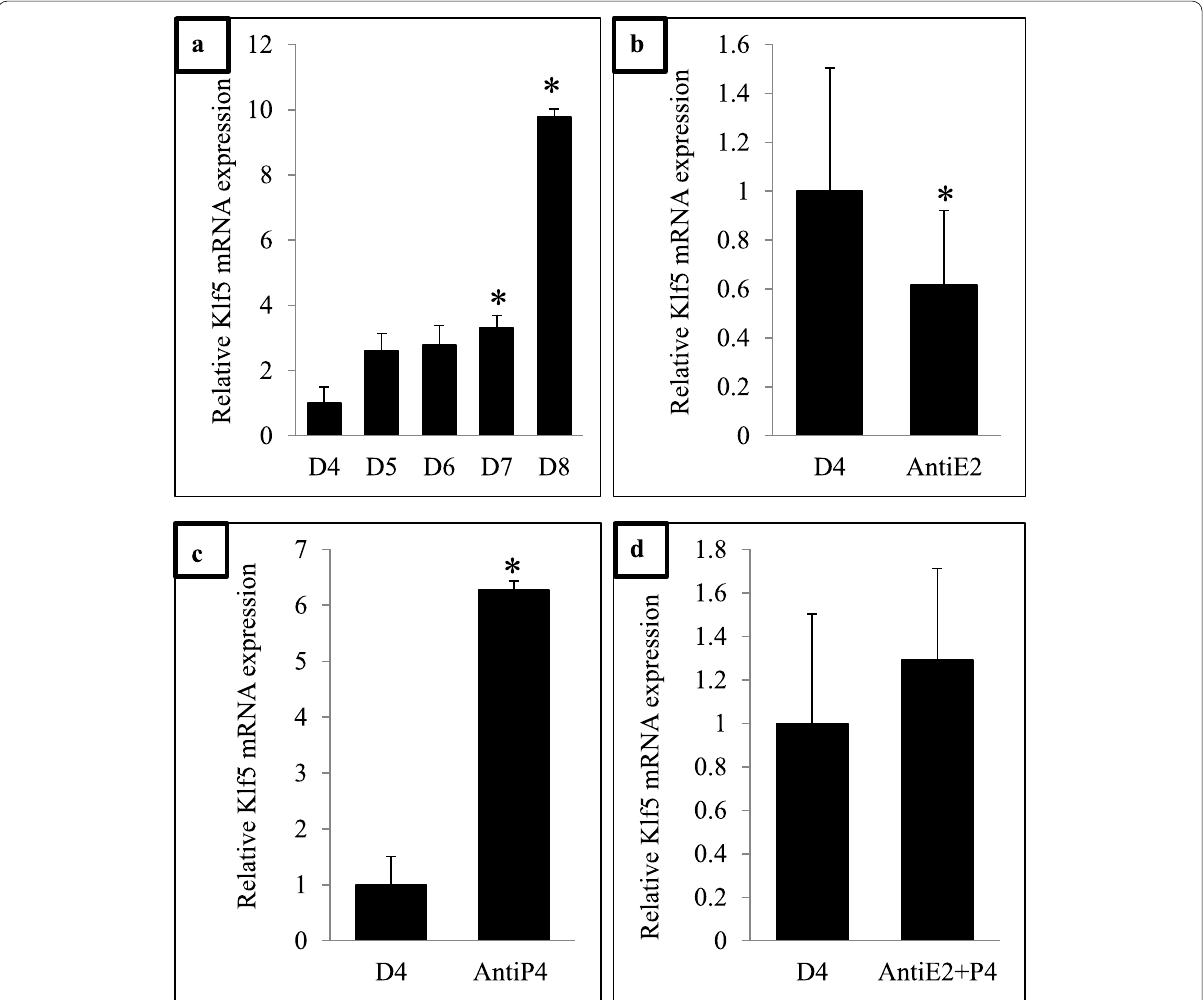
Fig. 12 Quantitative Real-Time PCR of Klf5 during D4 to D8 of gestation and in E2 and P4 antagonist treated uterus. The result revealed that Klf5 mRNA level is upregulated with the progression of gestation days ( a ), and there was a significant difference of Klf5 mRNA expression on D7, D8, and AntiP4-treated sample when compared with the D4 sample ( P < 0.05) ( b – d ). The data are represented as mean fold induction